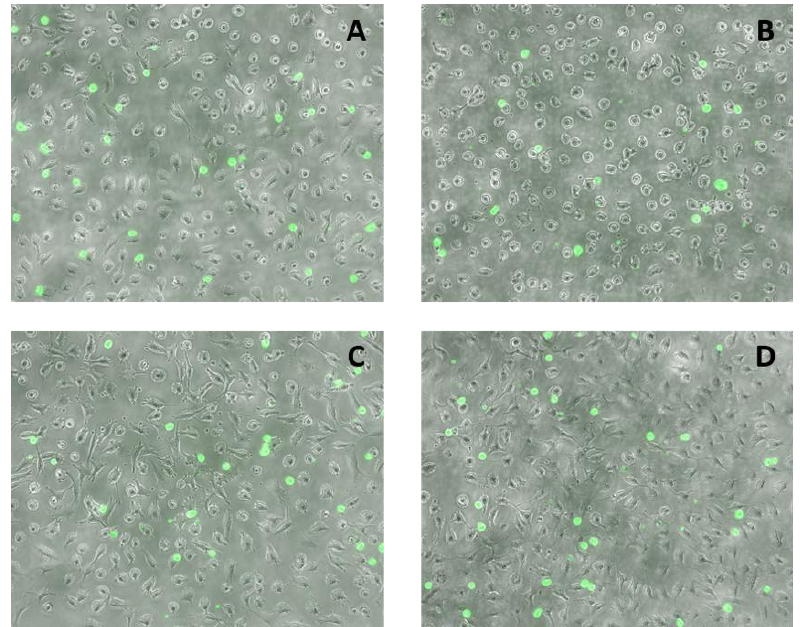
Figure 5. Images of THP-1 cell adhesion to EA.hy926 cells. Adhesion of THP-1 cells to EA.hy926 cells without pre-incubation with fatty acid (control ( A )) or with 48 h prior exposure to 10 µM linoleic acid ( B ), cis -9, trans -11 linoleic acid ( C ), trans -10, cis -12 linoleic acid ( D ), followed by incubation with a medium without fatty acids for 6 h and then 1 h co-incubation with calcein-labelled THP-1 cells. Attached THP-1 cells were visualised by fluorescence microscopy (Nikon Elipse Ti) at a magnification of 100× under transmitted light.